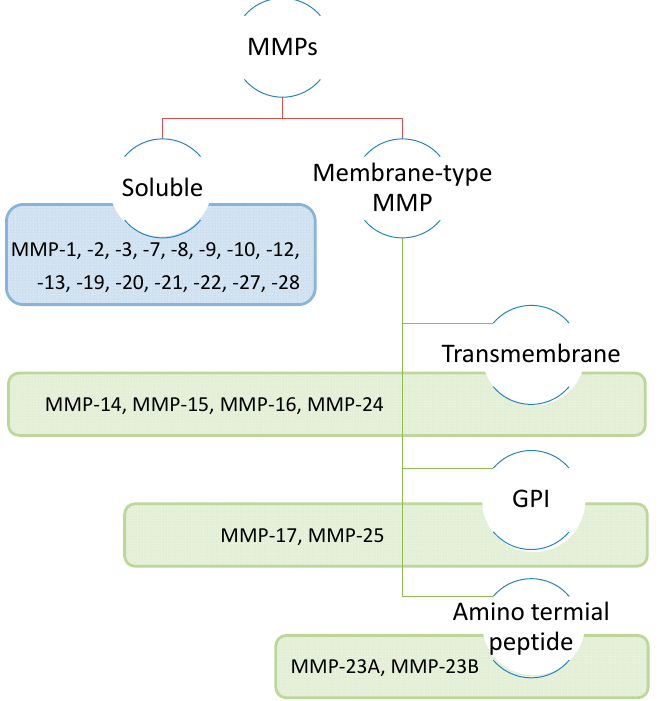
Figure 1. Classification of different Matrix Metalloproteinases (MMPs) according to their structure. Matrix Metalloproteases are either soluble (MMPs) or membrane-tethered (MT-MMPs). MMP14 (MT1-MMP), MMP15 (MT2-MMP), MMP16 (MT3-MMP), and MMP24 (MT5-MMP) are attached to the cell membrane by a transmembrane domain. MMP17 (MT4-MMP) and MMP25 (MT6-MMP) are linked to the cell membrane by a glycosylphosphatidylinositol anchor (GPI).